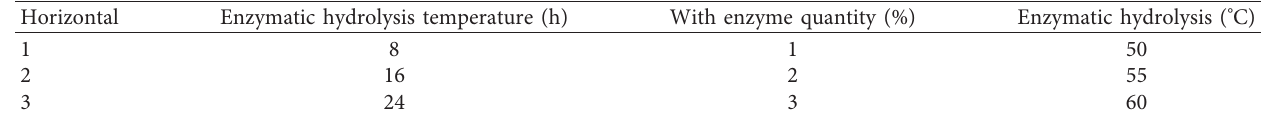
Table 7: Factor levels of the water enzymatic extraction method.